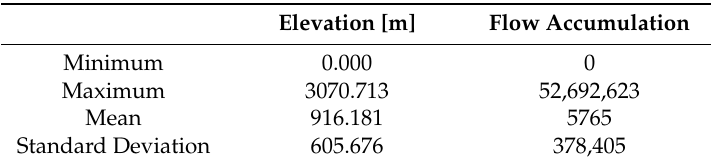
Table 1. The DEM (digital elevation model) and flow accumulation